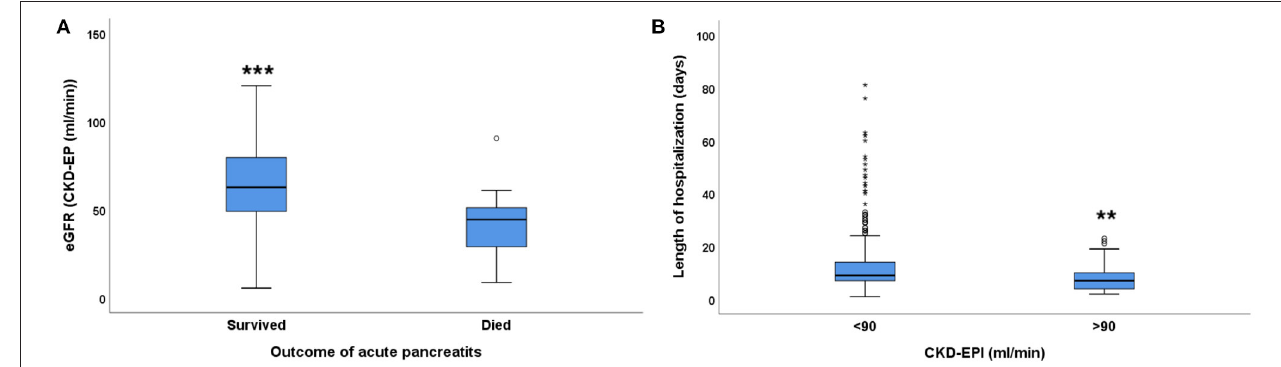
FIGURE 1 | The relationship between eGFR and acute pancreatitis outcome. (A) mortality, (B) length of hospitalization in days; median ± IQR, unpaired t -test with Welch correction, ** p = 0.001, *** p < 0.001. Small circles and stars represent outlier data.